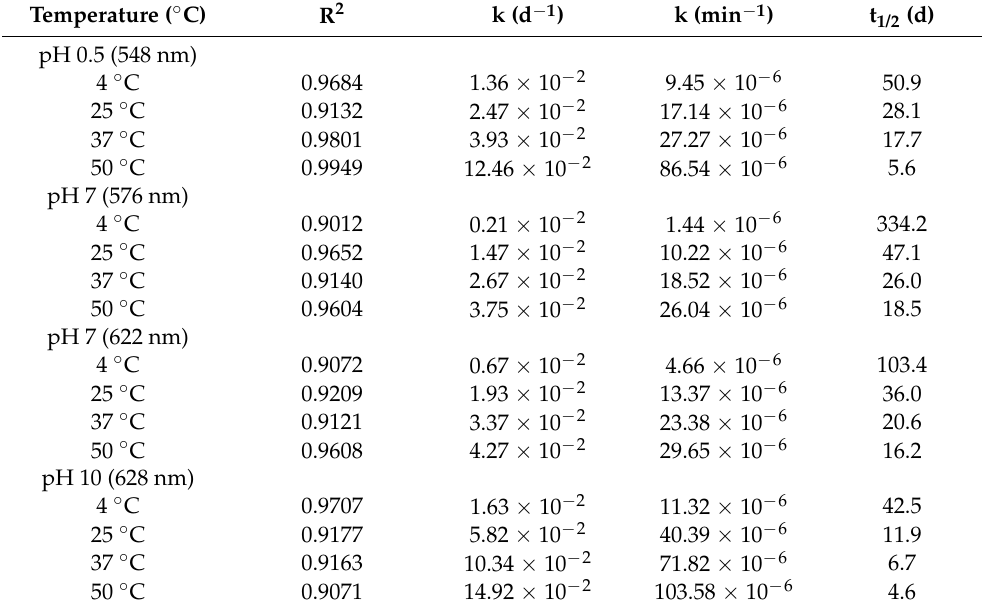
Table 1. Kinetic parameters of thermal degradation for CTAEs at different combinations of tempera- tures and